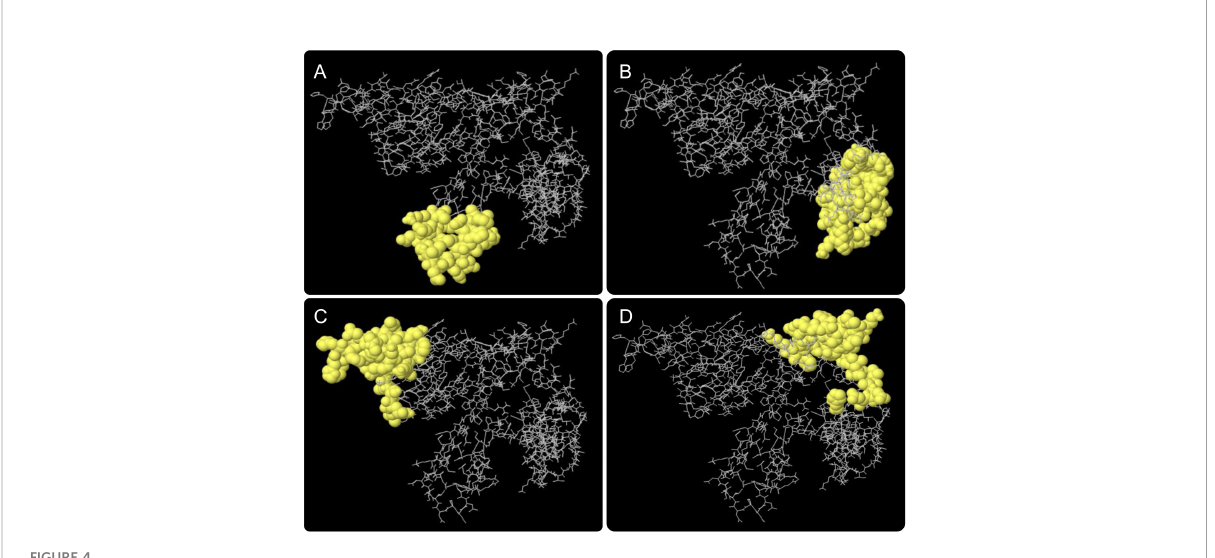
TABLE 4 The conformational B cell epitopes of the MP3RT vaccine predicted by the ElliPro. Residues Number